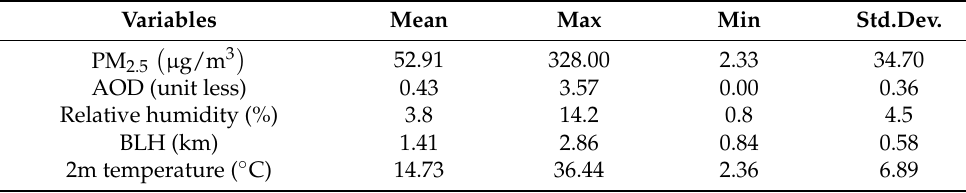
Table 3. The descriptive statistics of the variables of 2018.